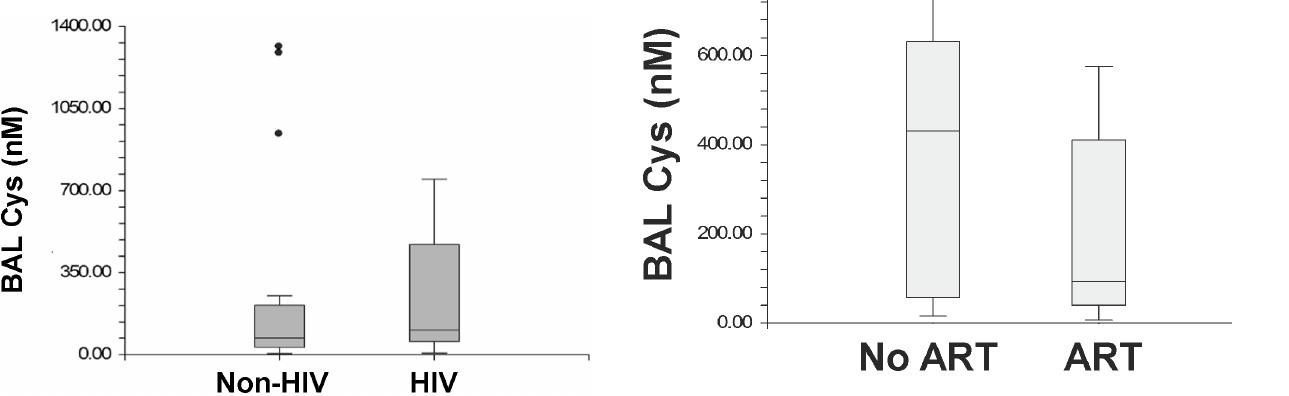
Figure 2. Box Plots of Cysteine Levels in Bronchoalveolar Lavage between non-HIV and HIV-infected Subjects.